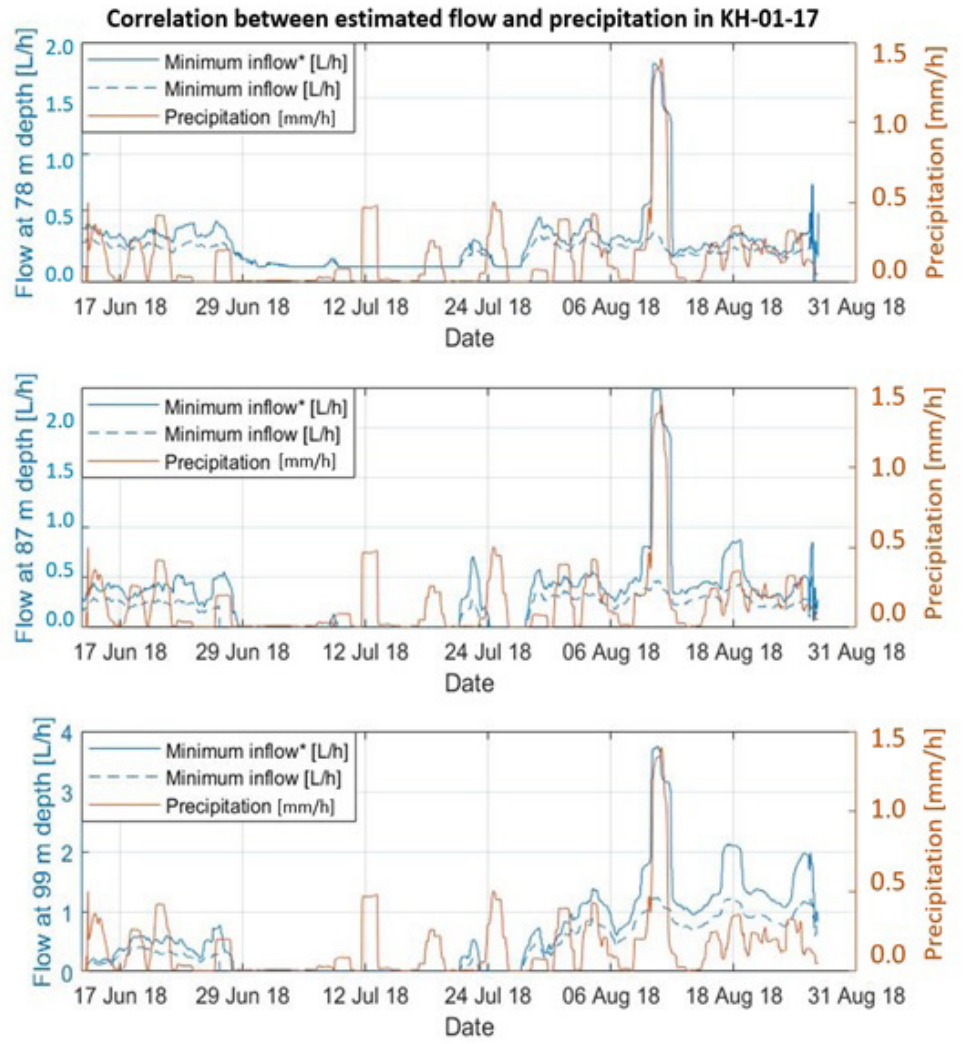
Figure 6. Correlation between moving daily averages of groundwater flow estimation at 78, 87 and 99 m depth in KH-01-17 and precipitation: The precipitation data are adjusted by 3.8–3.9 days, giving correlation factors of 0.69, 0.60 and 0.62. “Minimum inflow” is calculated based on that Tin in equation 5 equals the lowest measured temperature in the control volume, whereas “Minimum inflow*” applies the second lowest measured